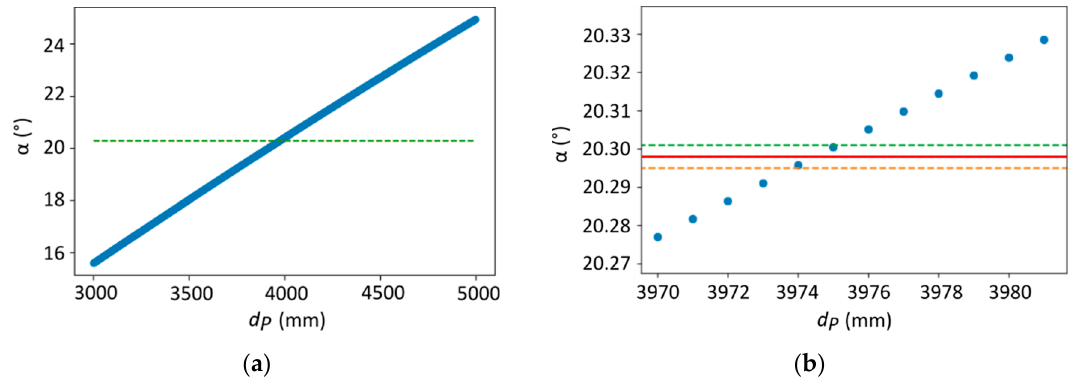
Figure 10. ( a ) Variation of the tilt angle in the reconstructed tilted RP for different virtual positions of the projector. The dashed line indicates the real value of the tilted angle. ( b ) Detail of the graph shown in ( a ) in proximity of the real value of d P . The straight line indicates the expected value of tilt angle, while the dashed lines indicate its uncertainty interval.